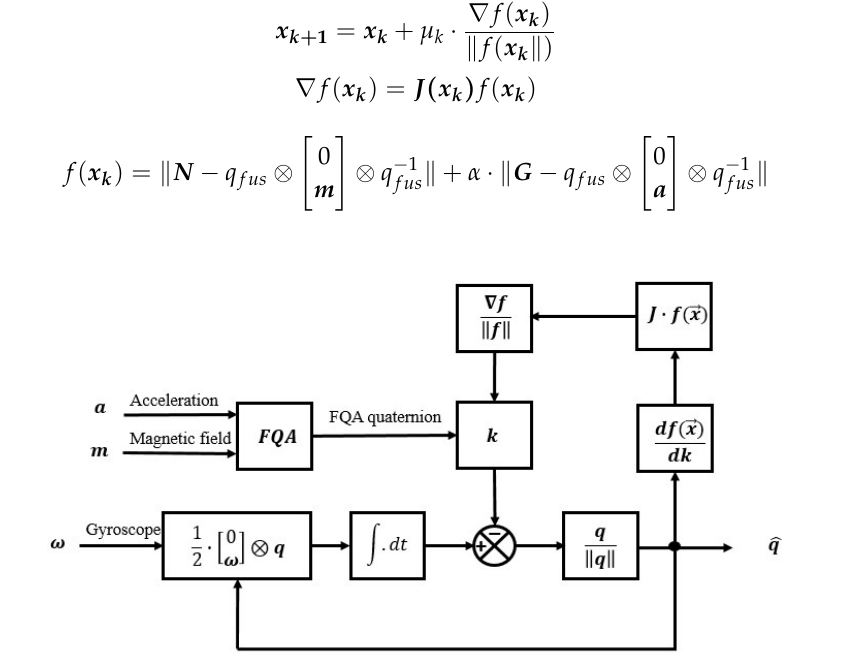
Figure 2. The block diagram of a complete implementation of this complementary